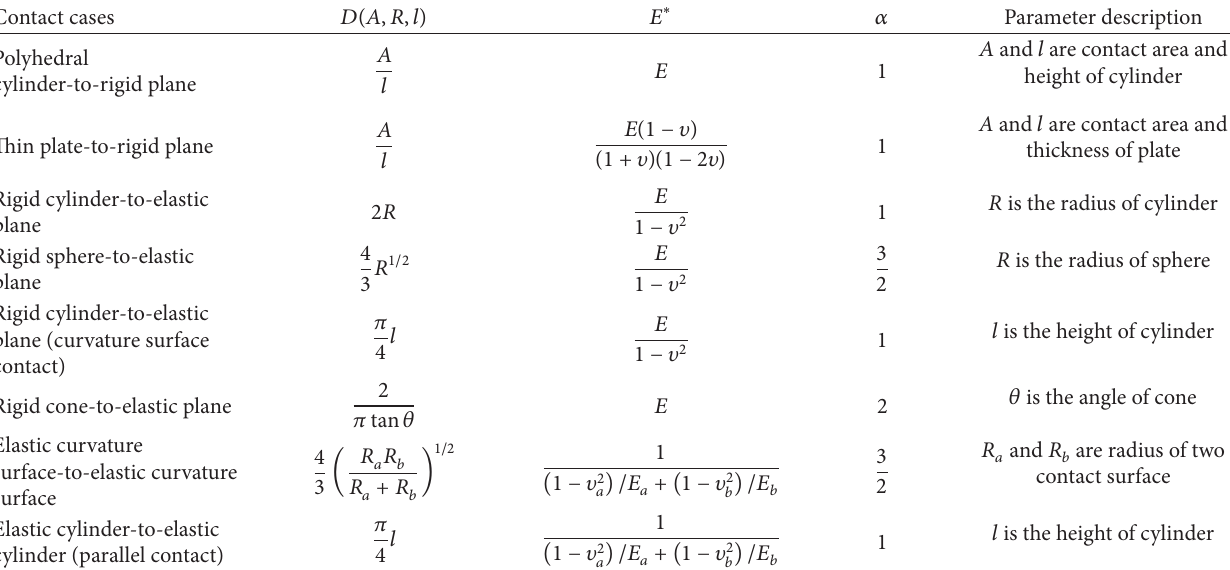
Figure 3: Linear viscoelastic constitutive models. Table 1: Expressions and descriptions of